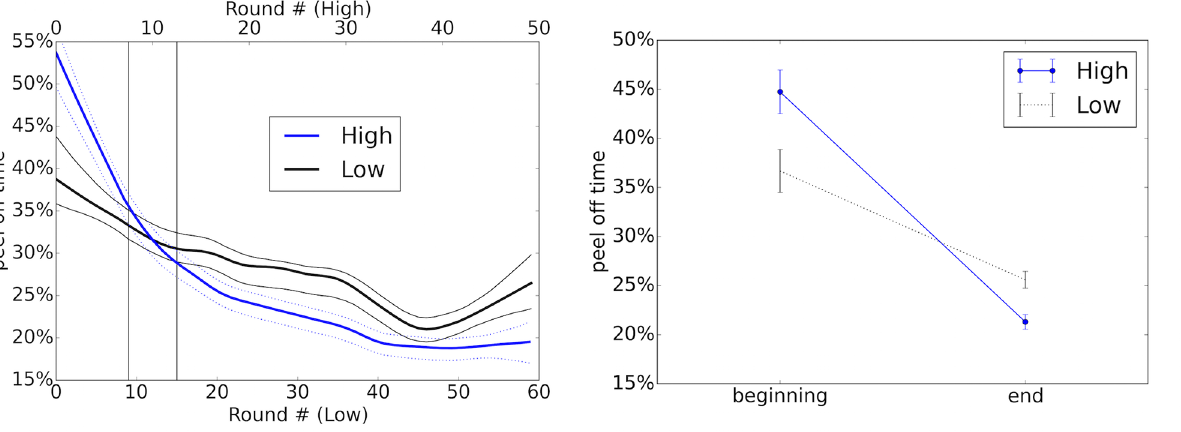
Fig 3. (a) Non-parametric local regression curve fitting peel-off times on each trial, broken down by ‘ high ’ and ‘ low ’ payoff conditions. Envelopes surrounding curves denote ± 1 (bootstrapped) standard deviation. Note that as conventions form, we predict a decrease in peel-off times, because there is a pre- determined action for both players to take in a given round. (b) Interaction plot comparing the mean peel-off time at the beginning of the experiment against mean peel-off times at the end (with intervals indicated by the arrows in (a)). We find a crossover effect, with the ‘ high ’ payoff condition beginning with higher peel-off times and ending with lower peel-off times. S2 Table demonstrates the robustness of this effect to different windows.